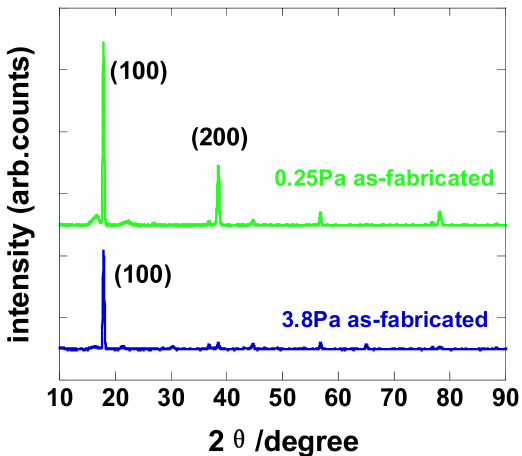
Figure 3. XRD patterns of LaB x thin films prepared under different working pressure. (300 nm on silicon